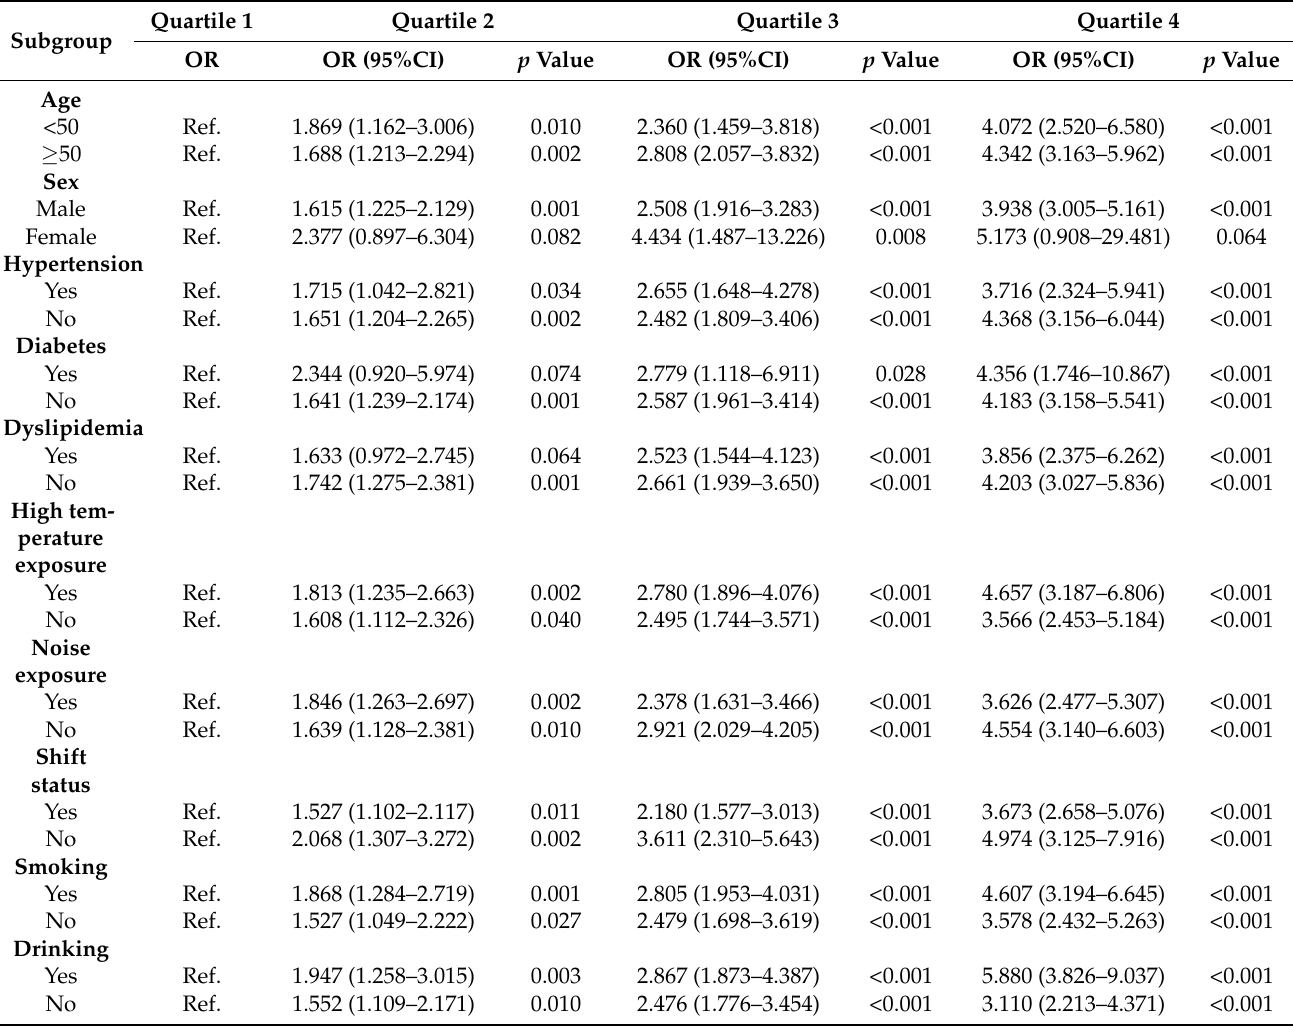
Table 3. Subgroup analysis of different CVAI levels and risk of CAS prevalence.